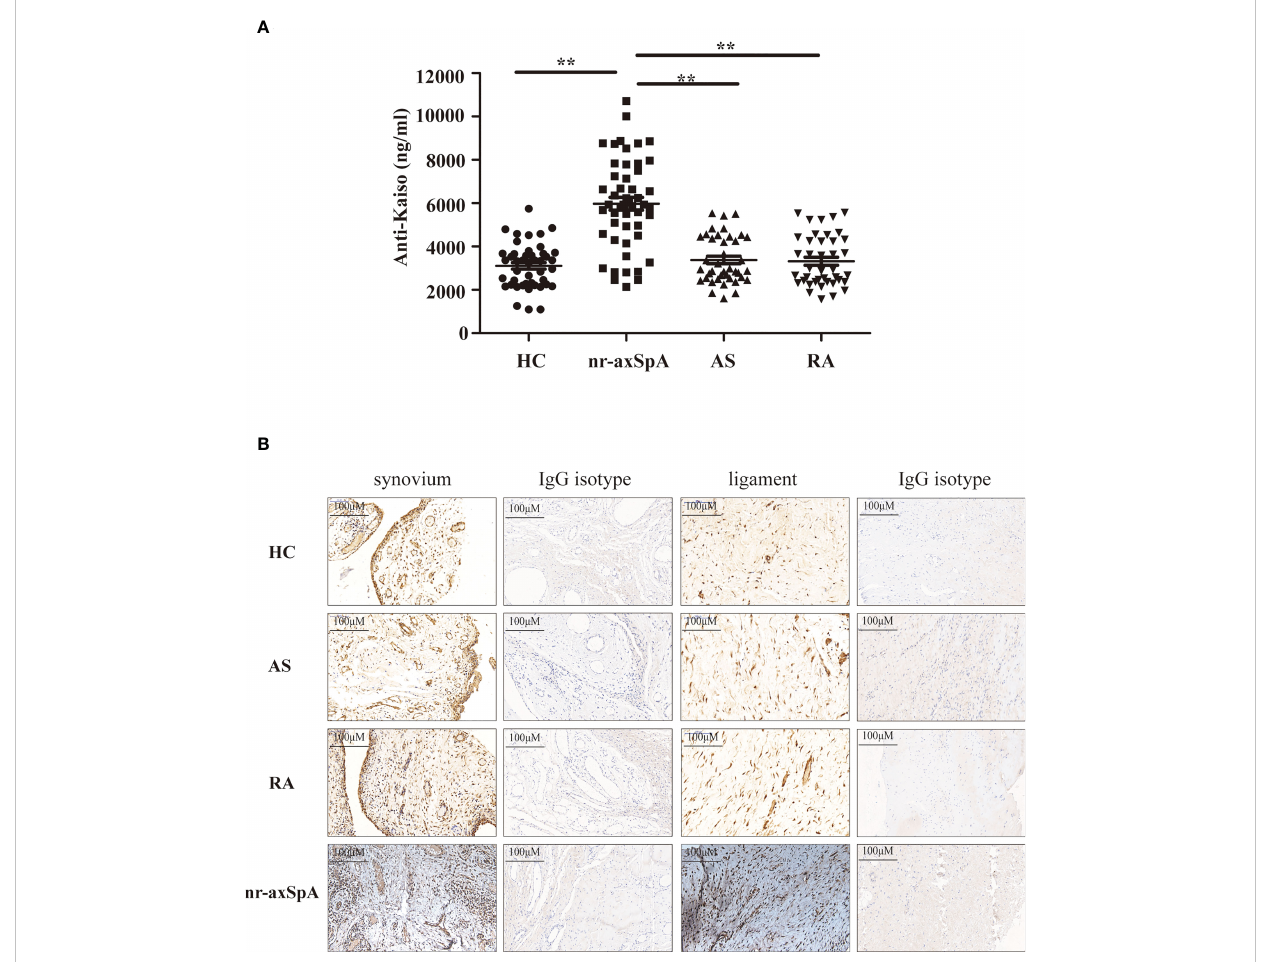
FIGURE 2 Validation levels of anti-Kaiso autoantibodies in the serum using the Meso Scale Discovery (MSD) assay system and the expression of Kaiso in the tissues detected using immunohistochemistry (IHC). (A) MSD analysis of anti-Kaiso autoantibodies in the serum of patients with nr-axSpA (n = 50), AS (n = 40), and RA (n = 40) and healthy controls (HC, n = 45). (B) Synovial and ligament tissues of HC, AS, RA, and nr-axSpA were stained with the anti-Kaiso antibody. Data are presented as mean ± SEM. **P <0.01 compared to patients with nr-axSpA. All IHC images are shown at ×100 magni fi cation and are representative of images from three independent